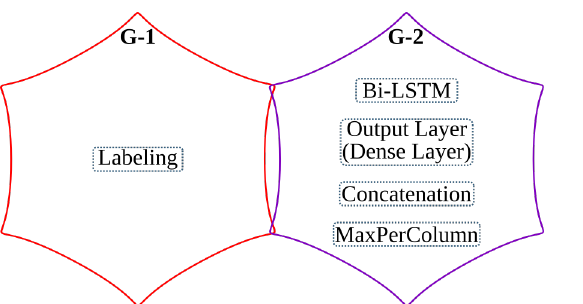
Figure 15. Operations of the text line recognition processing pipeline grouped from G-1 to G-2